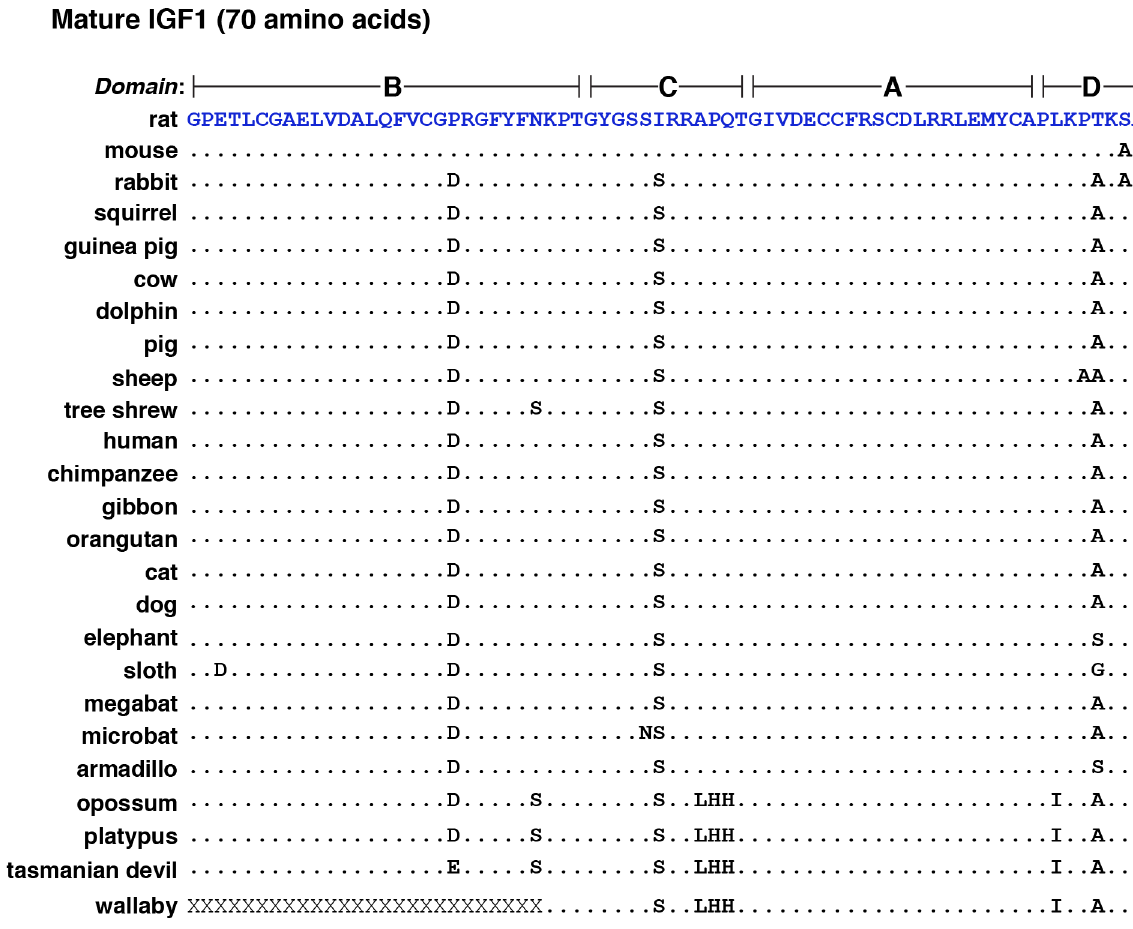
Fig 2. Alignments of mammalian IGF1 proteins. Amino acid sequenceof IGF1 from 25 mammalian species in single letter code. Identities are indicatedby dots, and differences amongspecies are depicted.X depicts an unknownamino acid. The color of rat IGF1 amino acids corresponds with the map in Fig